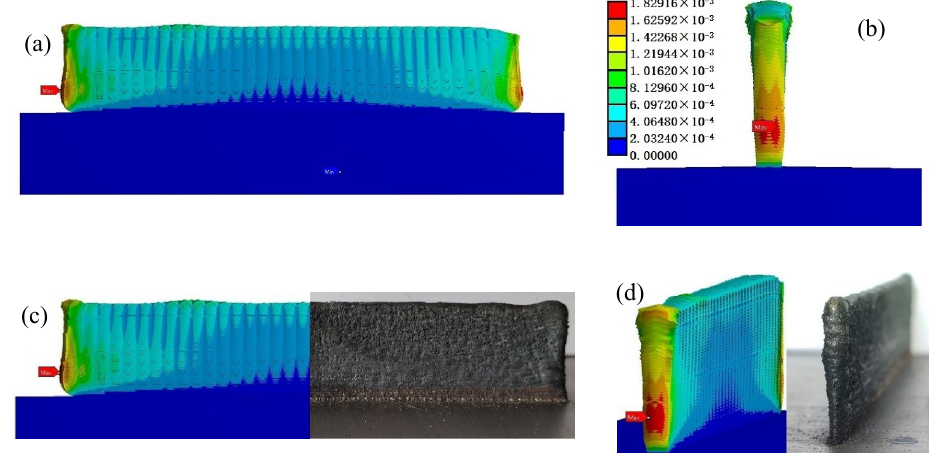
Figure 17. Finite element solution results of stress and deformation of the thin-walled parts (amplification: 17 × ): ( a ) surface deformation; ( b ) deformation at both ends; ( c , d ) comparison between simulation and actual deformation of thin-walled part.